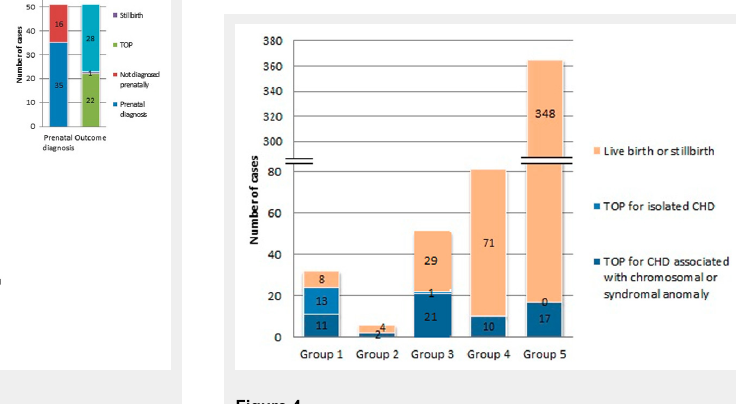
The percentage of prenatally diagnosed CHD cases in groups 1–5.